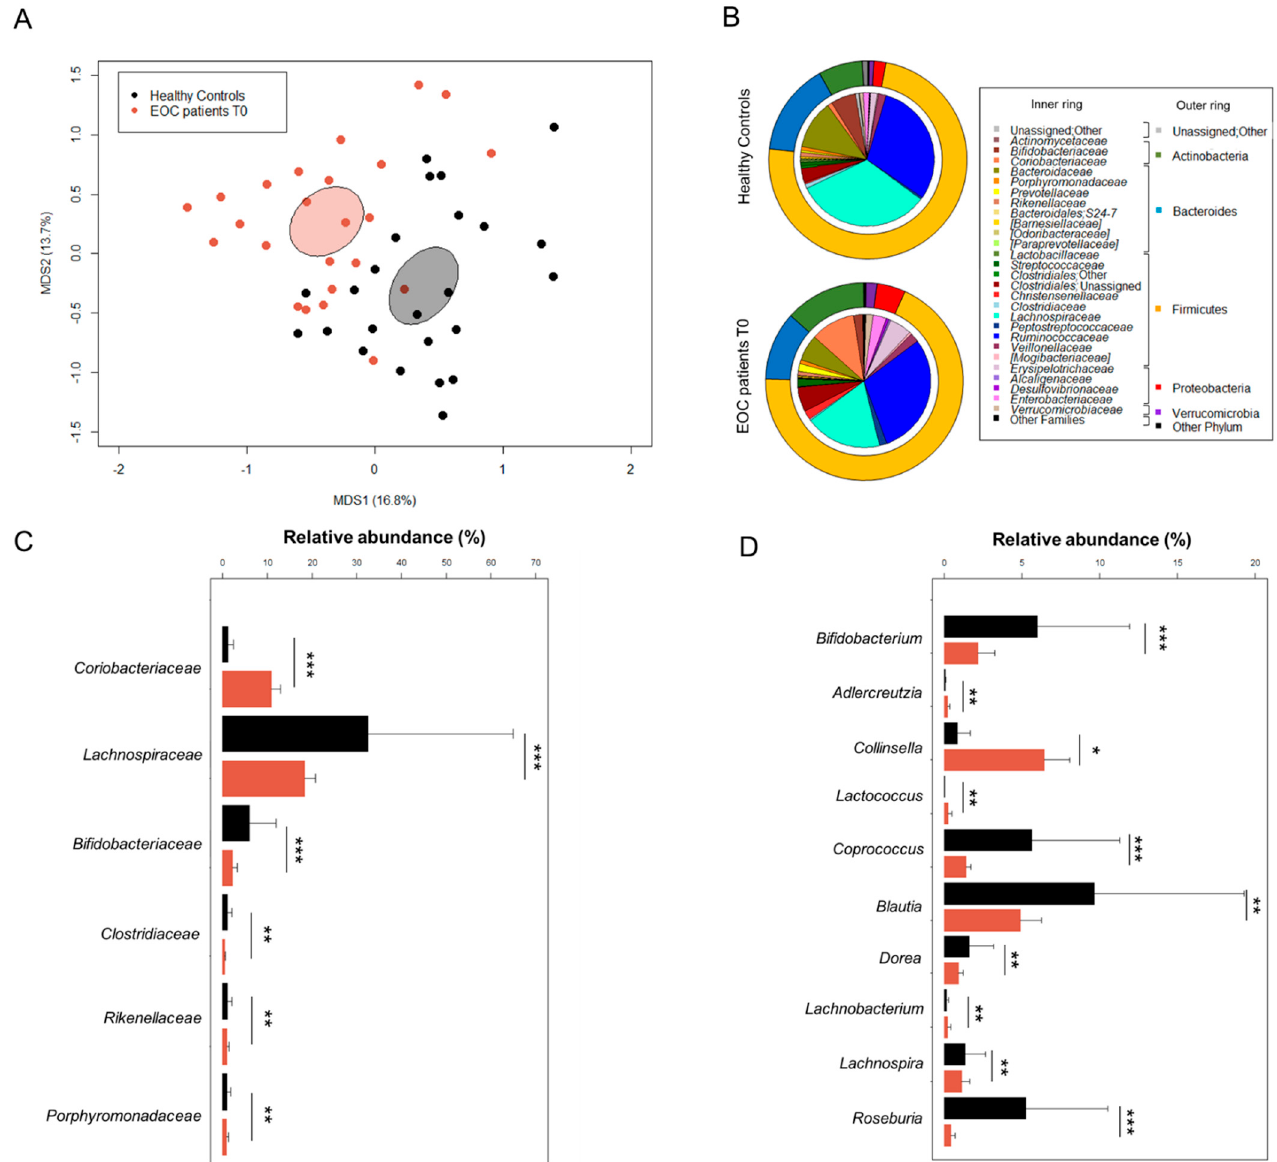
Figure 2. The gut microbiota of EOC patients at diagnosis compared to healthy women. ( A ) PCoA based on Bray–Curtis dissimilarity between the genus-level profiles of 24 EOC patients and 24 healthy age/BMI-matched women living in the same geographical area (across Italy). A significant separation between groups was found (permutation test with pseudo-F ratio, p = 0.001). Ellipses include 95% confidence area based on the standard error of the weighted average of sample coordinates. ( B ) Pie charts showing the average relative abundance of major phyla (outer ring) and families (inner ring) in the gut microbiota of EOC patients and healthy women. Only taxa with relative abundance > 0.1% in at least one sample are shown. Relative abundance (mean ± SEM) of families ( C ) and genera ( D ) differentially represented between groups (Wilcoxon test, * for p ≤ 0.05; ** for p < 0.01; *** for p < 0.001). Only families with mean relative abundance > 0.5% in at least one of the two groups are shown.